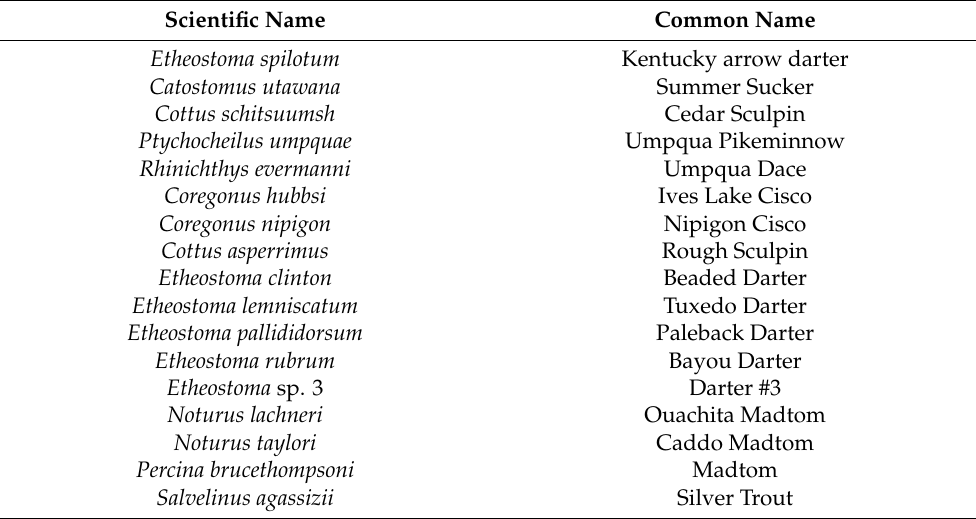
Table 3. List of freshwater fishes of the conterminous United States with more than 75% of their distribution categorized as more than 75% (highly) forested.